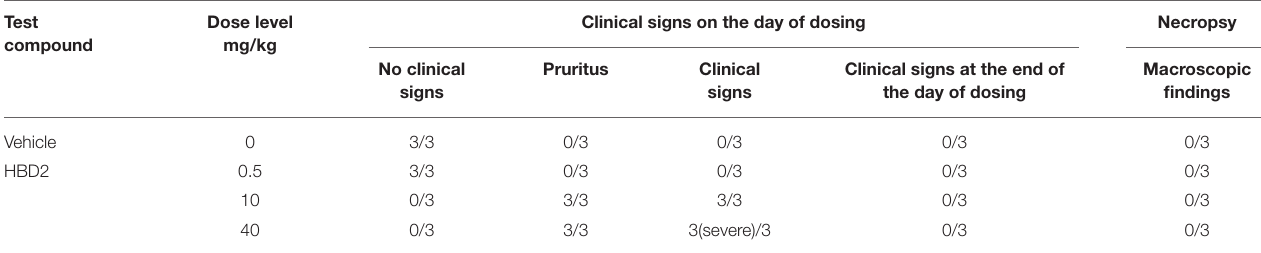
TABLE 1 | Clinical symptoms after subcutaneous administration of hBD2. Test